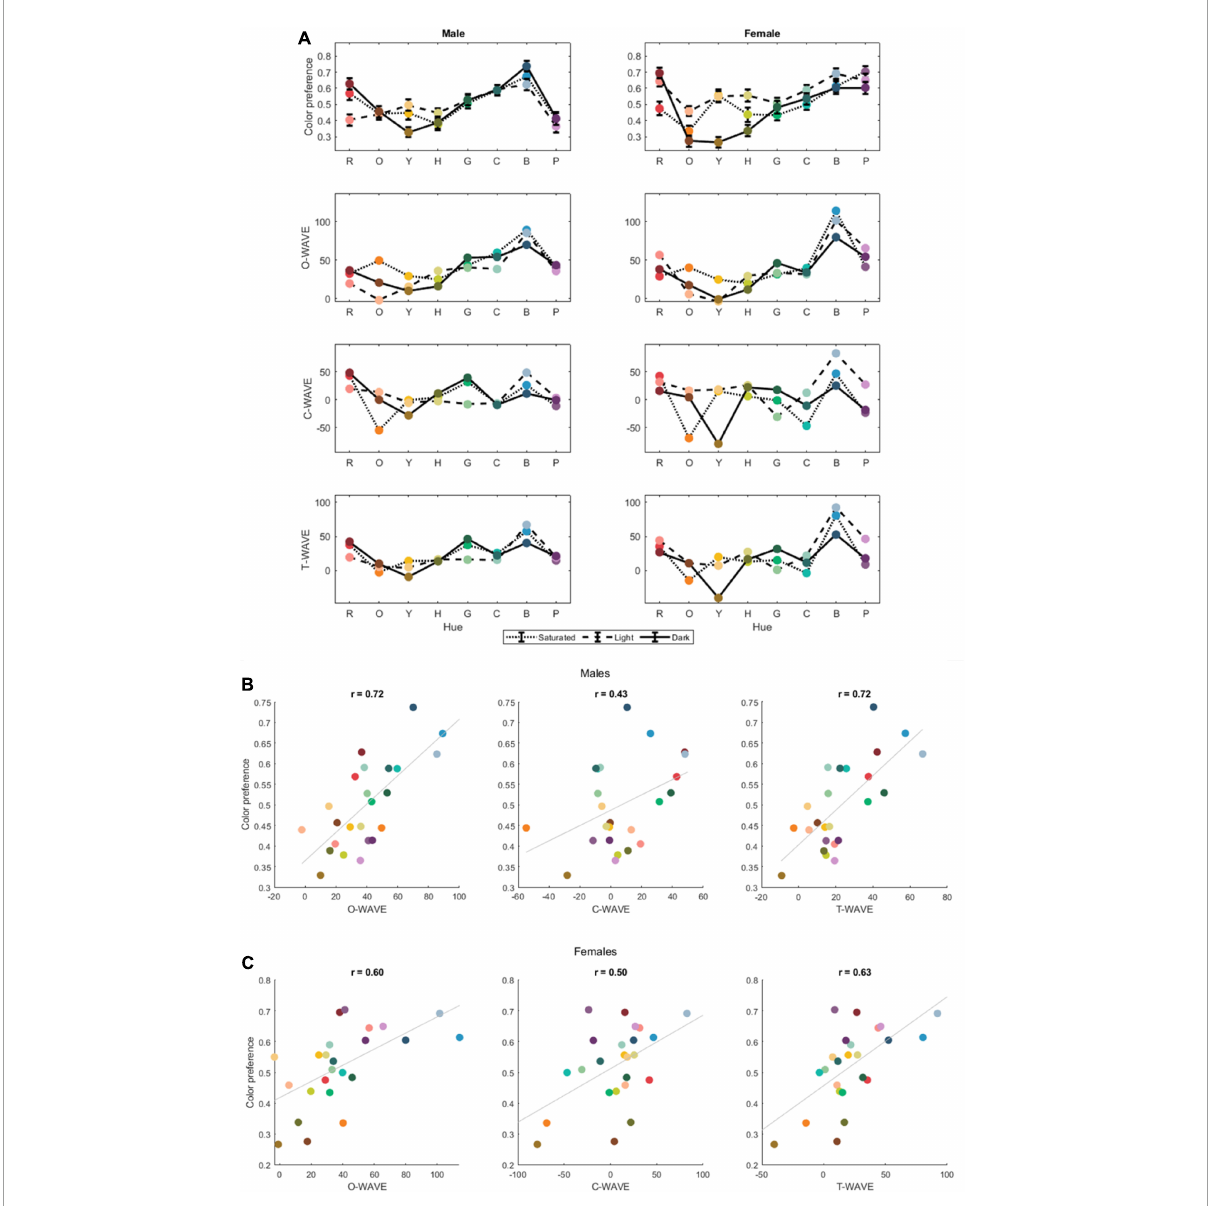
FIGURE2 (A) The average color preference rating and WAVEs for saturated (S), light (L), dark (D) versions of 8 colors, for object associations (O-WAVE), concept associations (C-WAVE) and both together (T-WAVE), for male and female participants separately. (B,C) The correlation plots between color preference and the three WAVE types: O-Wave, C-Wave and T-Wave for male (B) and female participants (C) .